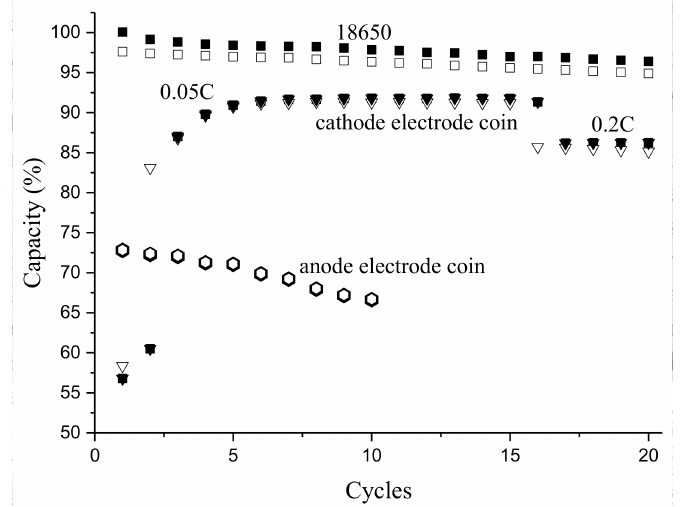
Figure 6. Normalized charge (filled symbols) and discharge (void symbols) capacity vs. the number of cycles for negative electrode (circle) and positive electrode (triangles) half cells from a similar 18650 cell compared to the 18650 cell with RE inserted (squares) vs. capacity during multiple charge/discharge cycles for the same